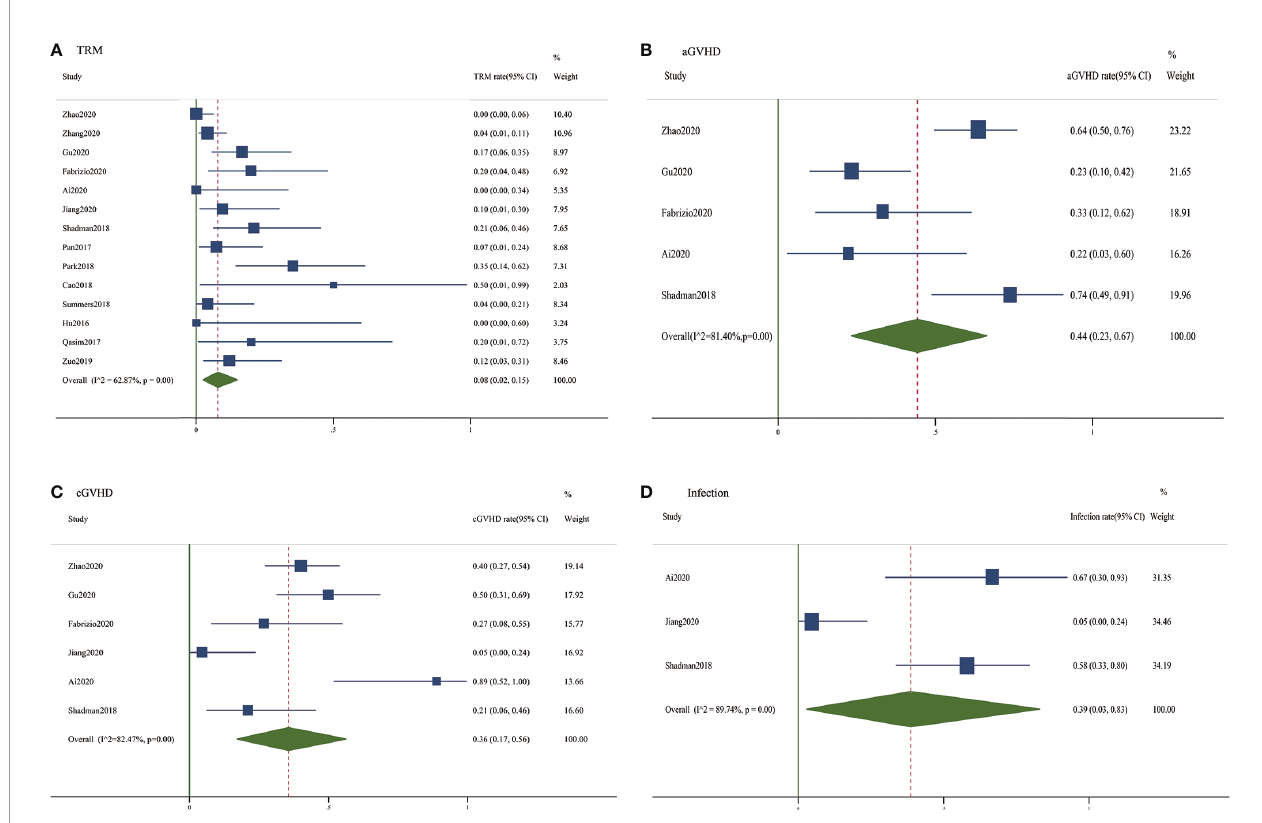
FIGURE 3 | Forest plots of safety outcomes of consolidative HSCT using pooled incidence rates. (A) Pooled transplant-related mortality rates; (B) Pooled acute graft- versus -host disease rates; (C) Pooled chronic graft- versus -host disease rates; (D) Pooled infection